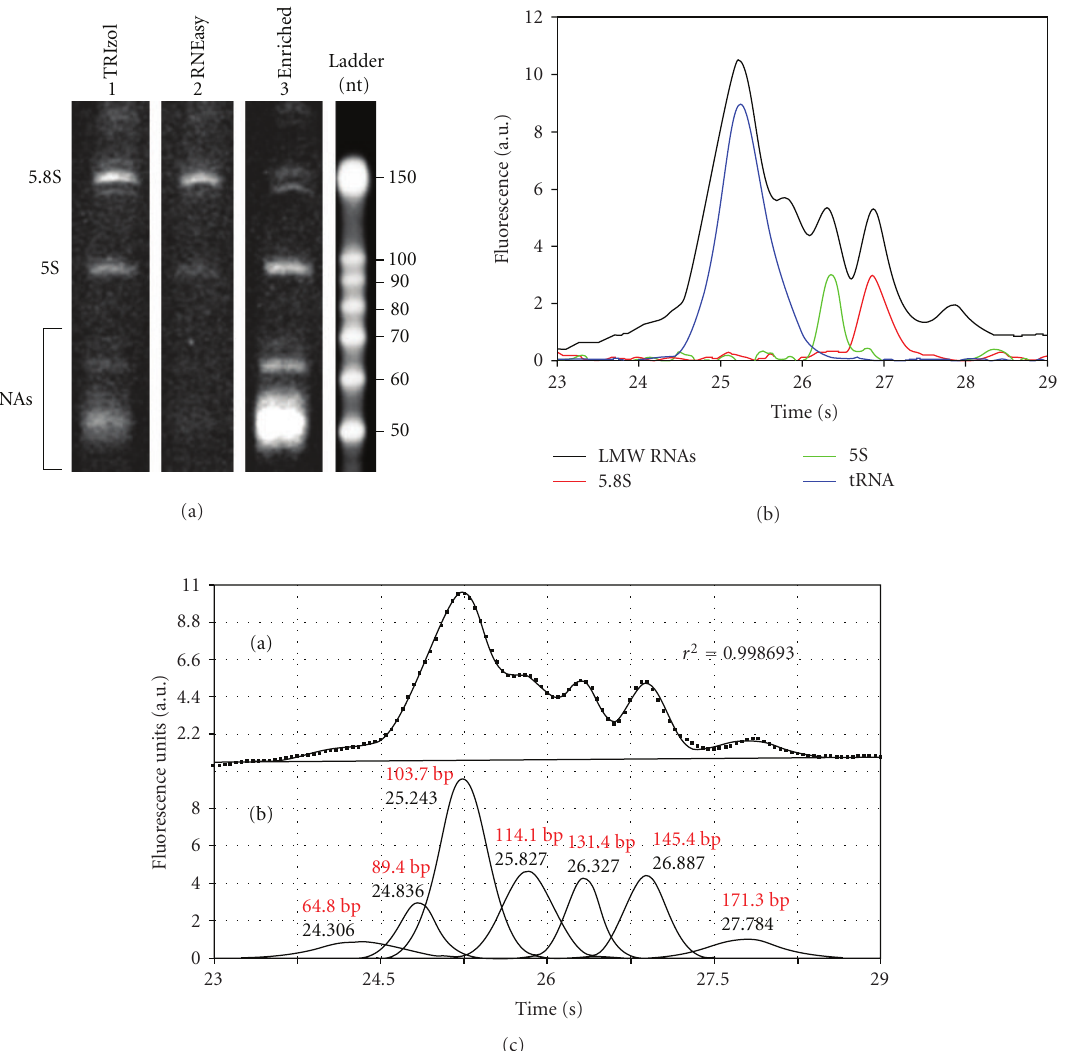
Figure 3: (a) Gel electrophoresis (polyacrylamide 15% stained with ethidium bromide) of LMW RNA samples (LCL) extracted with TRIzol reagent (lane 1), RNEasy kit (lane 2), and small RNA fraction enriched with MirVana kit (lane 3). LMW profile obtained with MirVana kit extraction is similar to that obtained with TRIzol reagent which is not shown for clarity. (b) Agilent 2100 Bioanalyzer electropherogram profile of LMW RNAs (LCL) extracted with TRIzol (black) superimposed on 5.8S (red), 5S (green), and tRNA (blue) bands eluted from polyacrylamide gel. (c) Lymphoblastoid (LCL) LMW RNA profile obtained after plotting the exported raw data from Agilent electropherogram ( ) together with the PeakFit fitted curve (solid line) and the component peak functions. Seven peaks below the LMW RNA profile were fitted by the software ( r 2 = 0 .